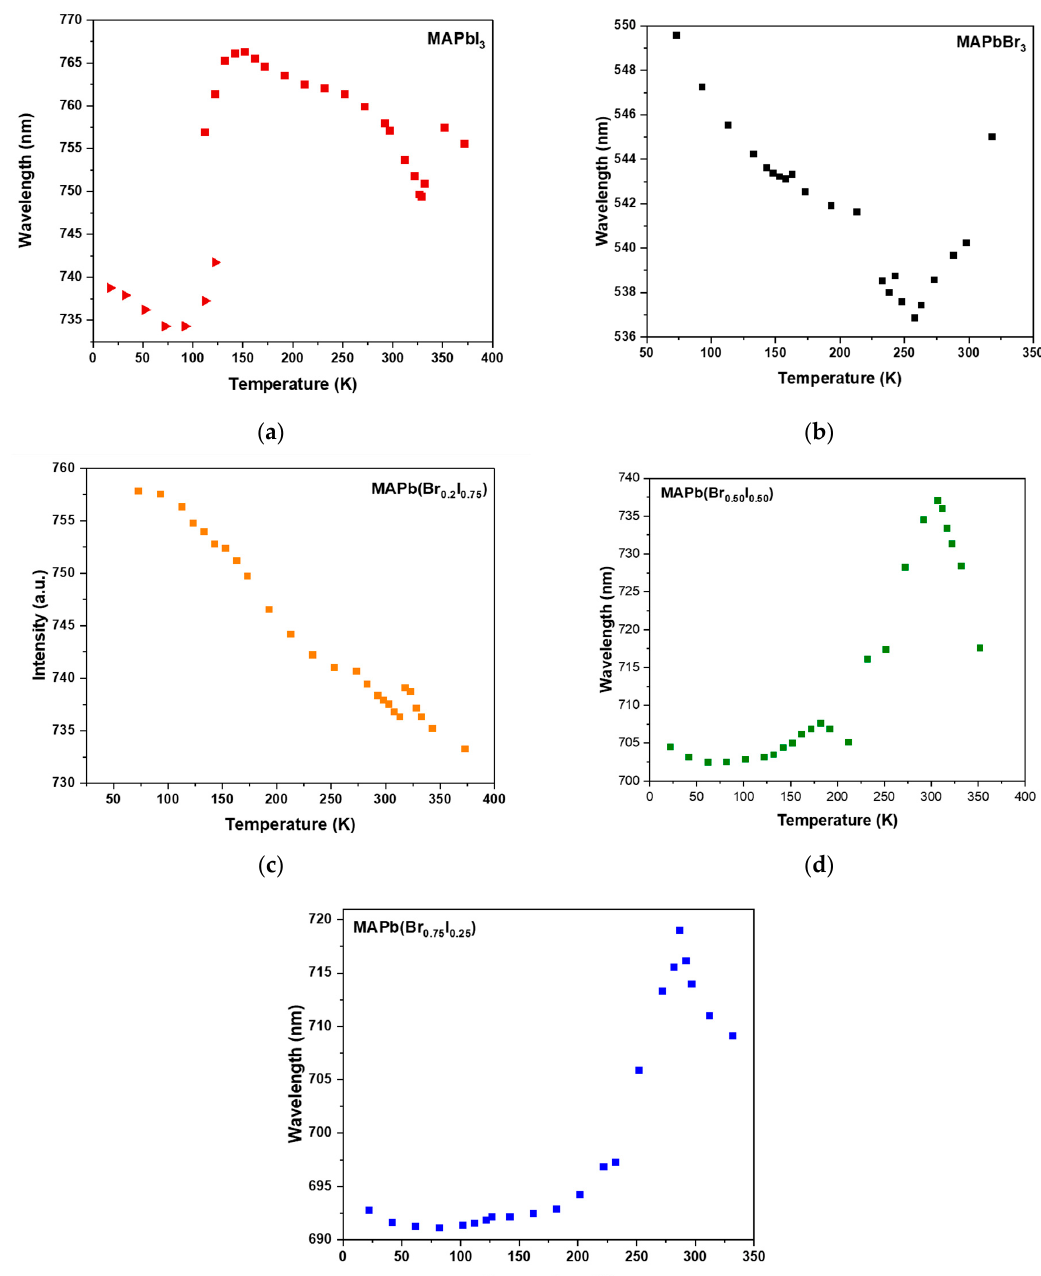
Figure 8. Temperature dependence of the emission band peak for the MAPb(Br x I 1 − x ) 3 perovskite films, ( a ) for MAPbI 3 , ( b ) MAPbBr 3 , ( c ) MAPb(Br 0.25 I 0.75 ) 3 , ( d ) MAPb(Br 0.50 I 0.50 ) , ( e ) MAPb(Br 0.75 I 0.25 ) 3 . MAPbBr 3 and MAPbI 3 pass through two-phase transitions with a temperature in- crease: from the orthorhombic to tetragonal phase and then, from the tetragonal to